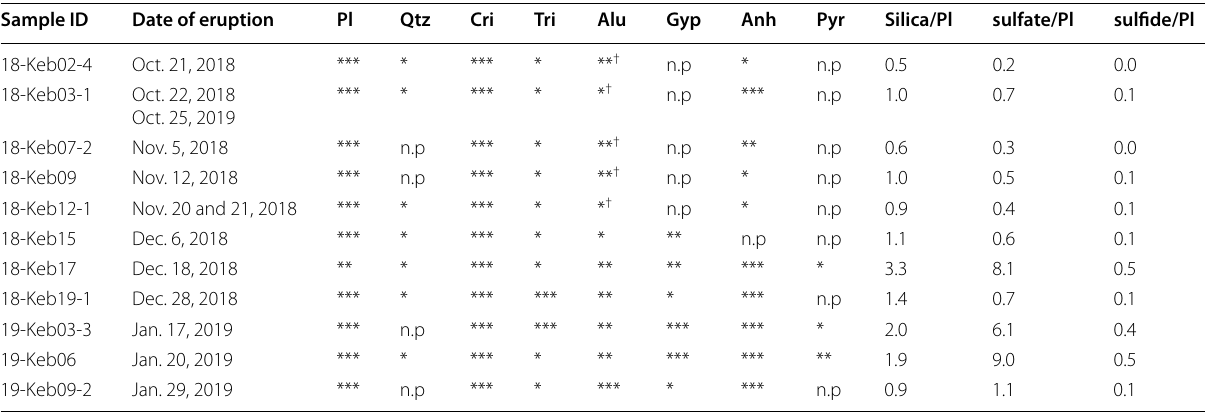
The intensities of X-ray peaks in the XRD analysis are shown as: ***Intense; **Weak; *Minor; and n.p. no peaks were determined Mineral abbreviations; Pl plagioclase including anorthite and albite, Trd tridymite, Crs cristobalite, Qtz quartz, Gp gypsum, Anh anhydrite, Alu alunite and natro-alunite (minamiite); and Py pyrite The peak intensities of alunite basically used K-alunite and those with † are natro-alunite (minamiite) Ratio of peak value refers to the total peak intensity of maximum peaks of silica minerals of tridymite, cristobalite, and quartz (silica/Pl); sulfate of gypsum, anhydrite, and alunite (sulfate/Pl); and sulfide of pyrite (sulfide/Pl), divided by maximum peak intensity of plagioclase (Pl), respectively